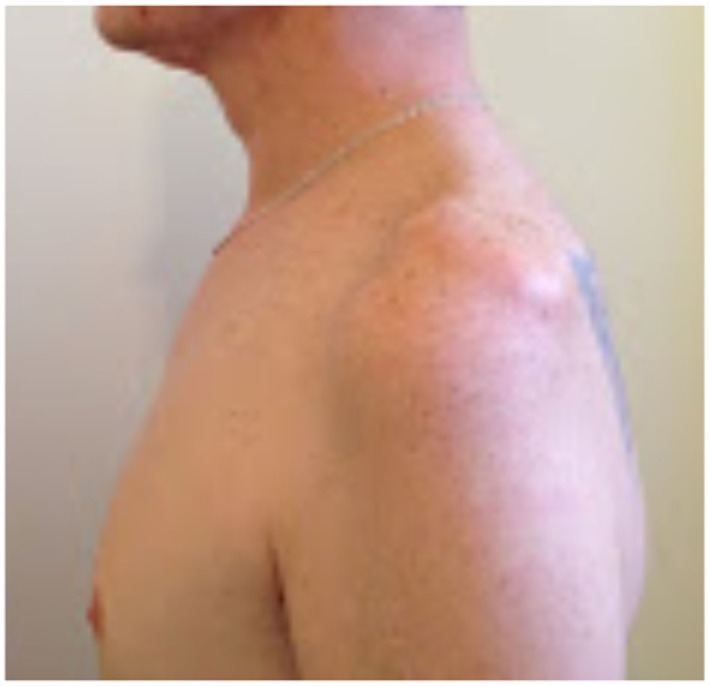
Left lateral view.